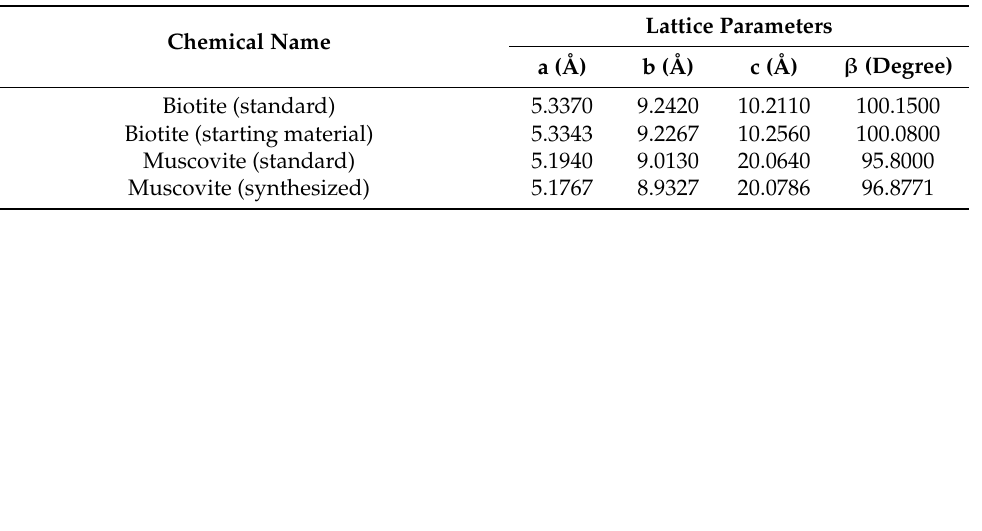
Table 2. Calculated and standard lattice parameters for biotite and